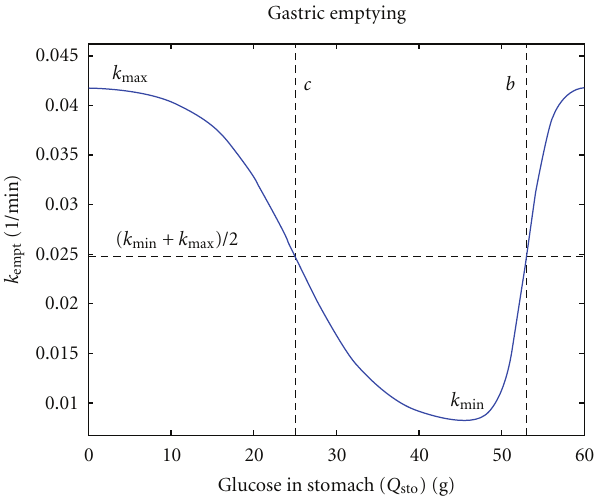
Figure 6: Change of gastric emptying rate ( k empt ) using the meal model of Dalla Man et al. [15] for 60 g CHO.